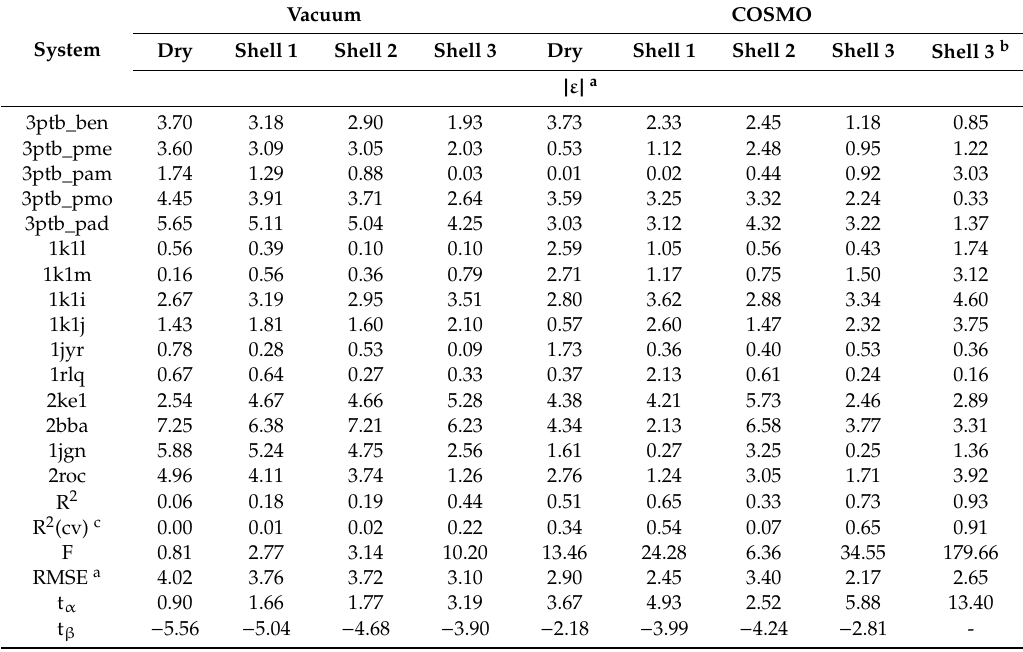
Table 2. Per-system residuals ( ε ) and statistical parameters of linear regressions obtained with di ff erent water models.